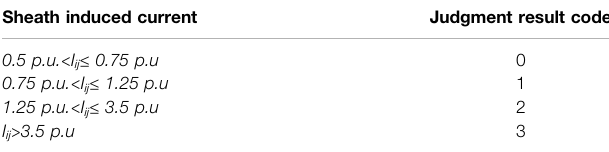
TABLE 3 | Judgment standard for induced current of cable sheath Sheath induced current Judgment result code